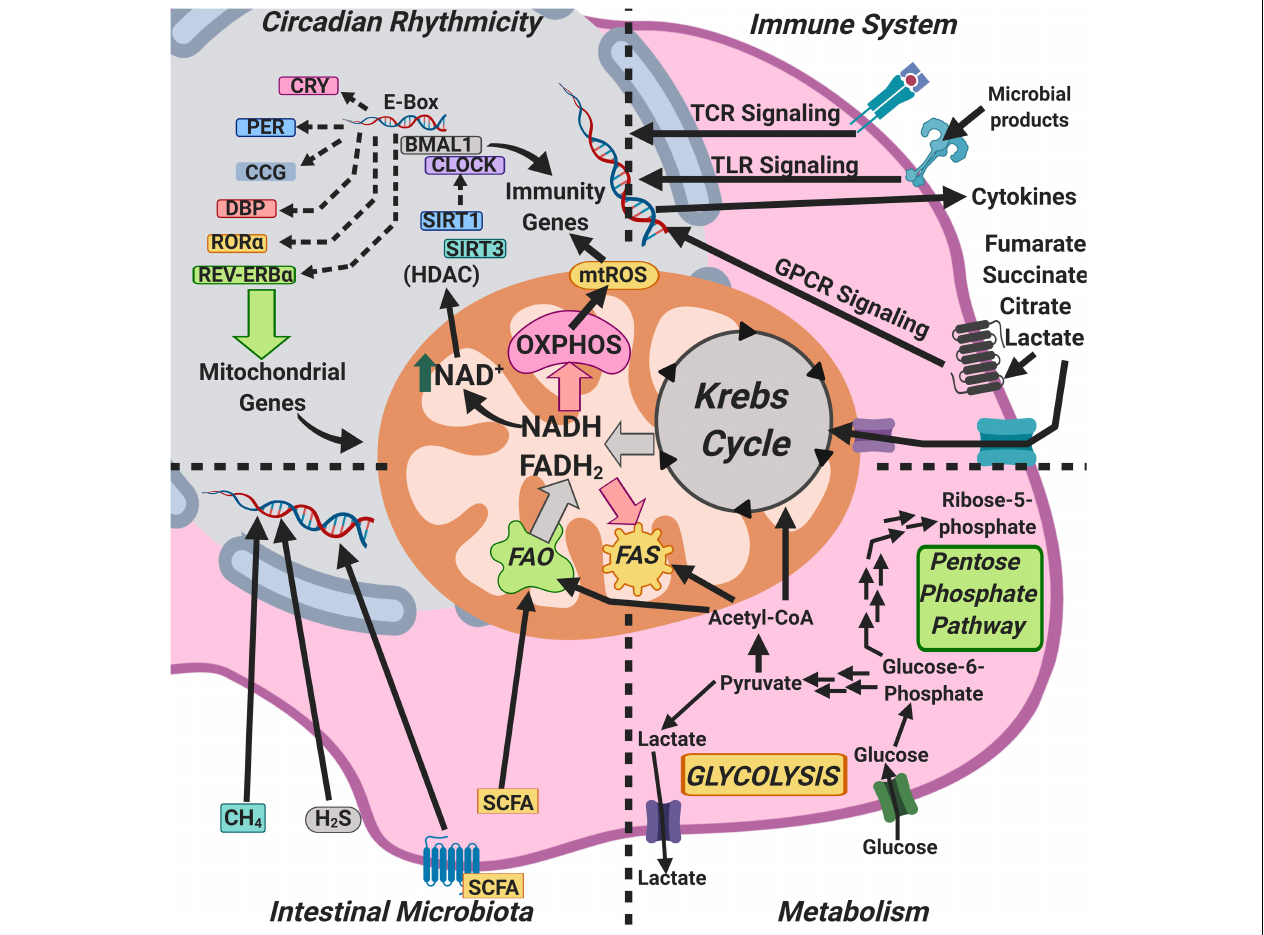
FIGURE 4 | Mitochondria as an integrative hub coordinating circadian rhythms, metabolism, the microbiome, and immunity.